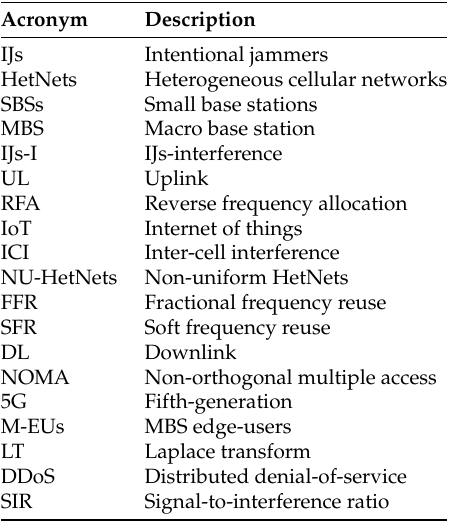
Table 1. List of